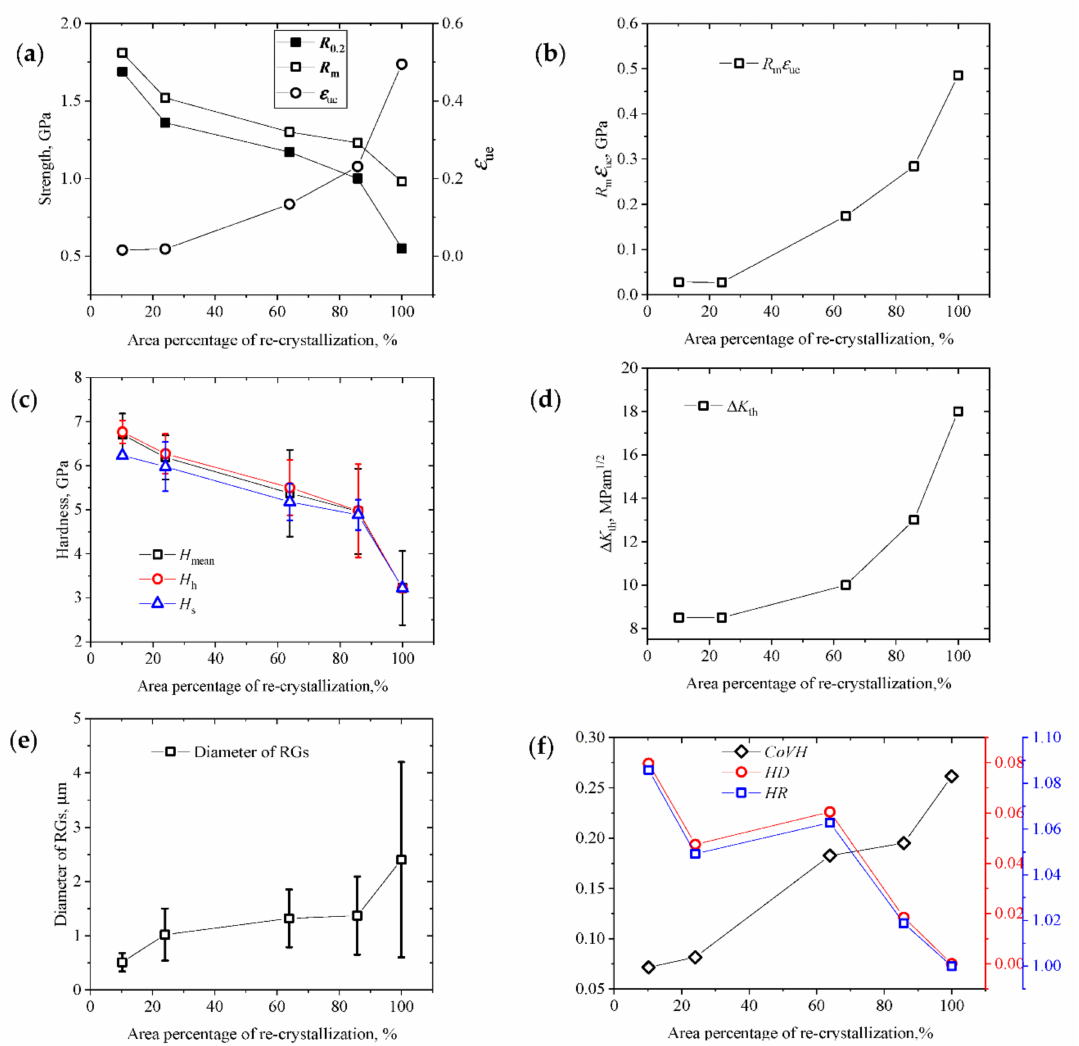
Figure 8. Experimental data versus the area percentage of recrystallization. ( a ) Tensile strengths and uniform elongations. ( b ) Product of the strength and uniform elongation. ( c ) Nanoindentation hardness. ( d ) Fatigue crack propagation thresholds. ( e ) Diameters of the RGs. ( f ) Hardness parameters for quantifying the heterostructured